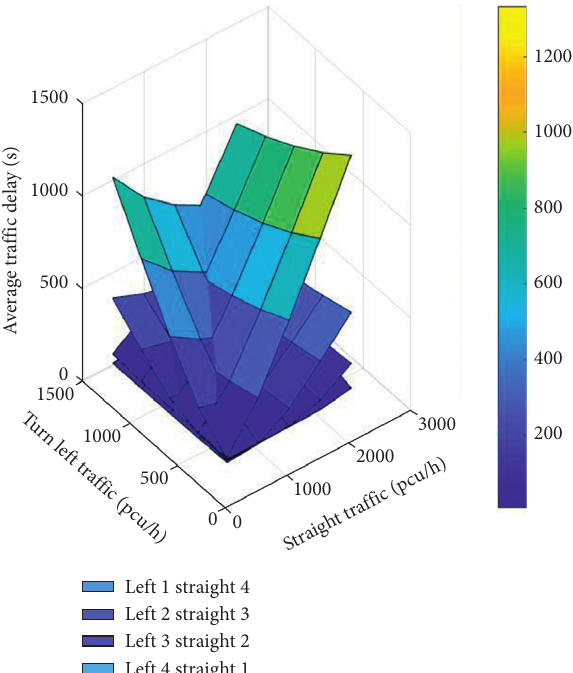
Figure 12: Change in the two-way delay under different lane combinations on five entrance